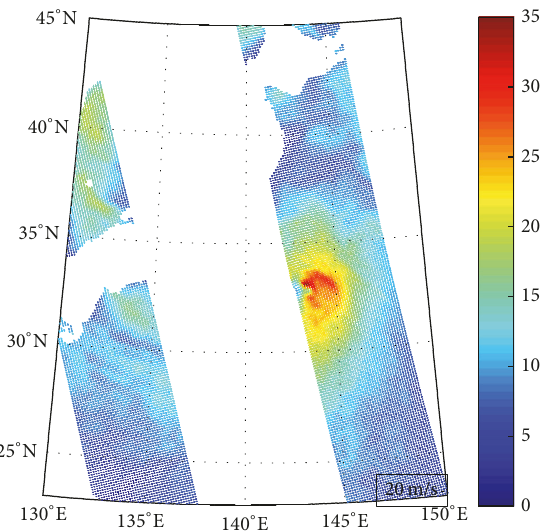
Figure 3: ASCAT wind field of typhoon “Lionrock” with a resolution of 12.5